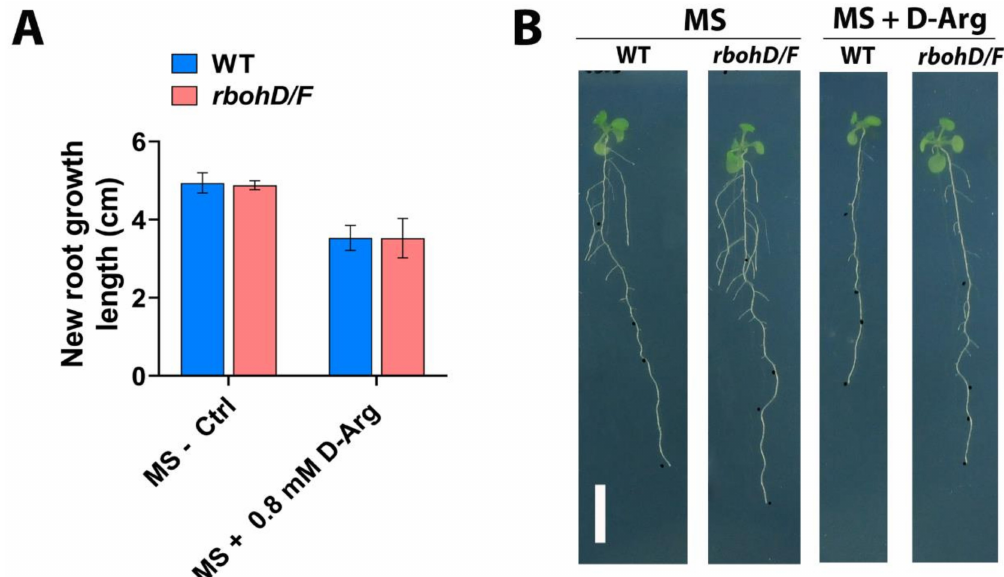
Figure 4. Effect of D-Arg treatment on WT and AtrbohD/F root growth indicates that H 2 O 2 accumulation is not caused by NADPH oxidases. Five-day-old seedlings at the same developmental stage were transferred to new media containing water (Ctrl) or 0.8 mM D-Arg and treated for 6 days. ( A ) New root growth length of WT and AtrbohD/F . ( B ) Seedling phenotype. Scale bar = 1 cm. Data shown are averages ± SD (n >